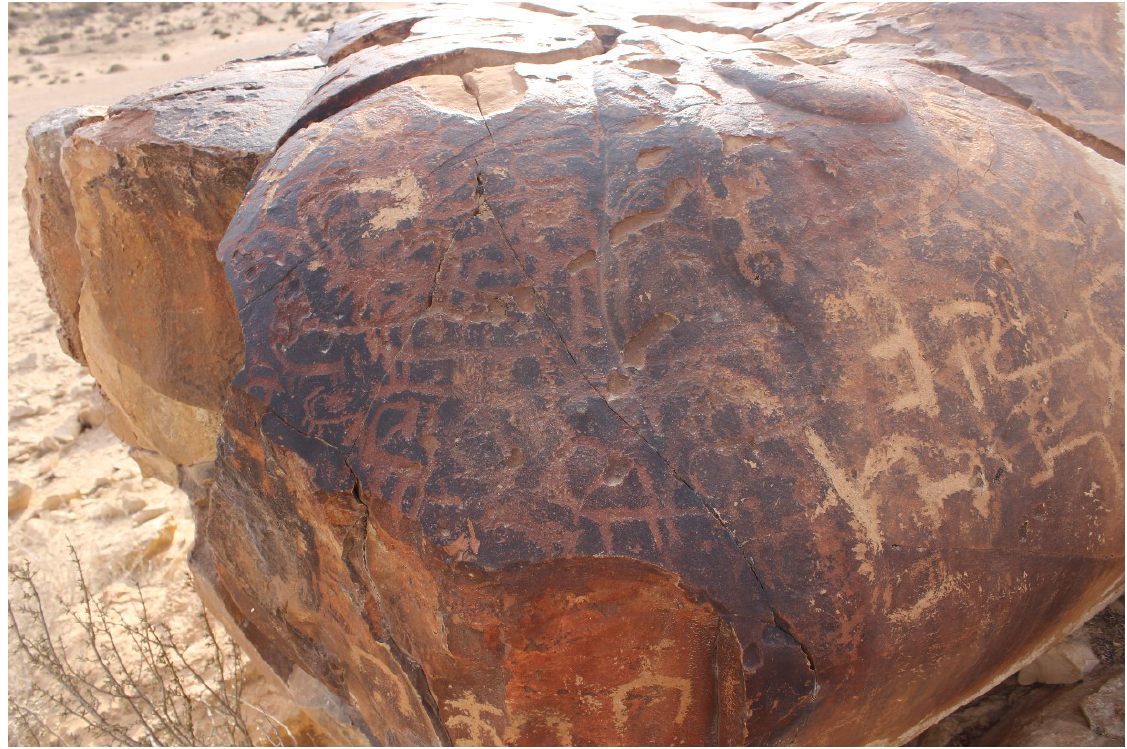
Figure 3 Rock art panel from Giva’t HaKtovot area (Photo by D.